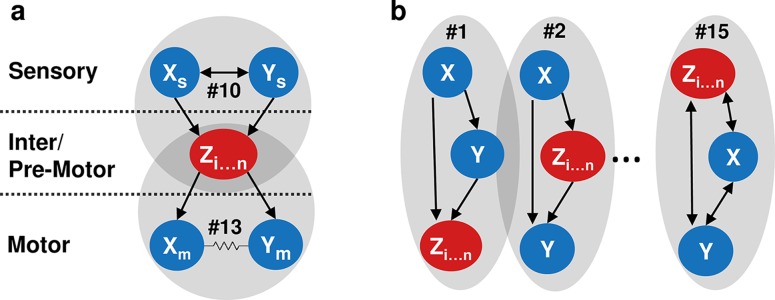
A coarse-grain reconstruction of the network based on homogenous sets of common neighbors reveals a simple network architecture that is intuitive to understand.(a) The mutually regulating and mutually regulated sets, triads #10 and #13, respectively, are found in defined layers: the mutually regulating sets (#10), enriched in the sensory layer, enable signal amplification and retention (short-term memory). The mutually regulated sets (#13), found almost exclusively at the motoneuron layer, support coordinated motoneuron activity that underlies the fine-orchestrated undulations. (b) Typical examples of additional significantly enriched homogeneous common neighbor sets. In these homogenous sets X and Y pair of neurons are mainly found on different layers of the network. Such sets can be particularly beneficial in mediating signal flow across layers. For example, sets #1 and #2 illustrate the typical Feed-forward Loop, a motif known for its potential functional roles in signal detection, filtering and more.